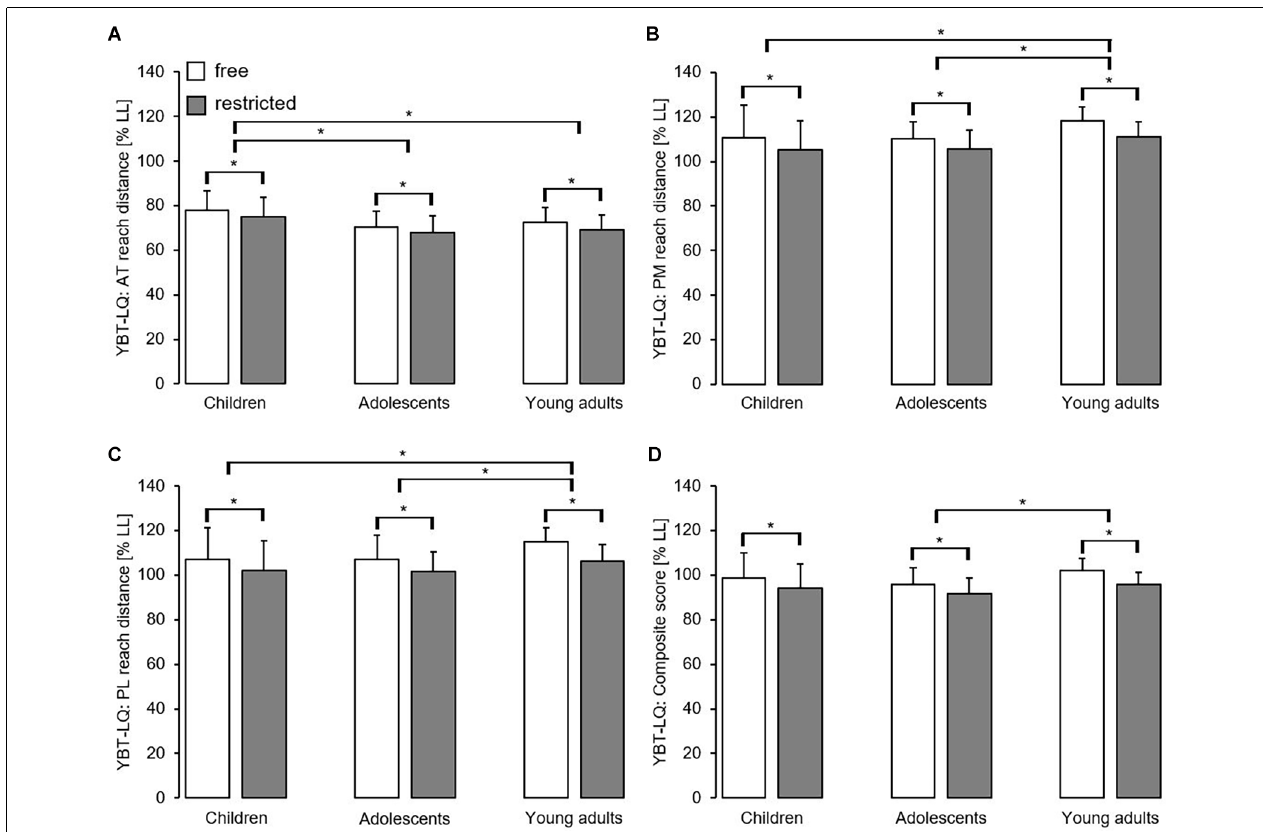
FIGURE 4 | Effect of free vs. restricted arm movement by age group on proactive balance performance using the Lower Quarter Y Balance test consisting of the anterior reach direction (A) , the posteromedial reach direction (B) , the posterolateral reach direction (C) , and the composite score (D) . Values are means ± standard deviations. *Significant difference ( p < 0.05) between free and restricted arm movement conditions and age groups. AT, anterior; LL, leg length; PL, posterolateral; PM, posteromedial; YBT-LQ, Lower Quarter Y Balance